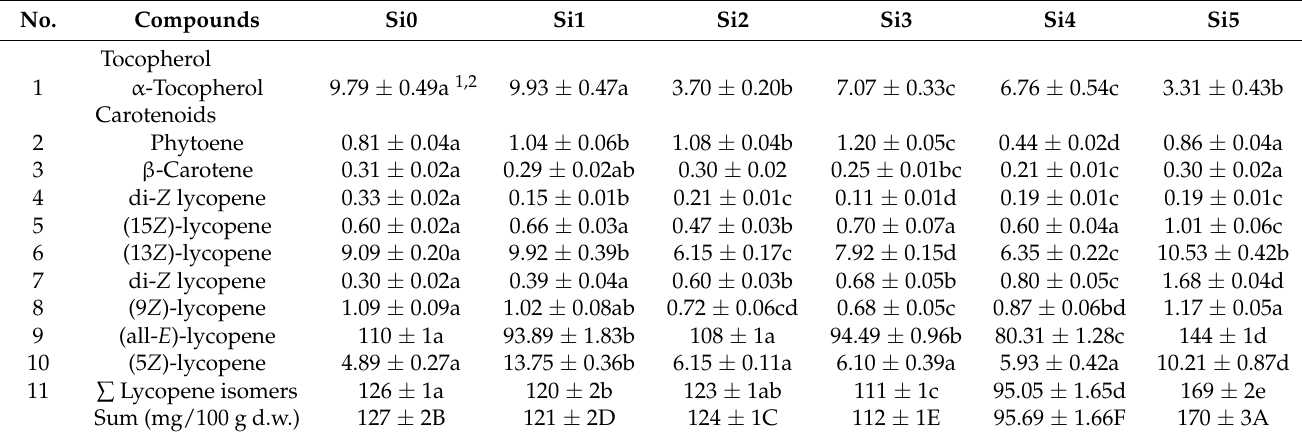
Table 4. Quantification of tocopherols and carotenoids (mg/100 g d.w.) in the fruit skin + pulp of cherry